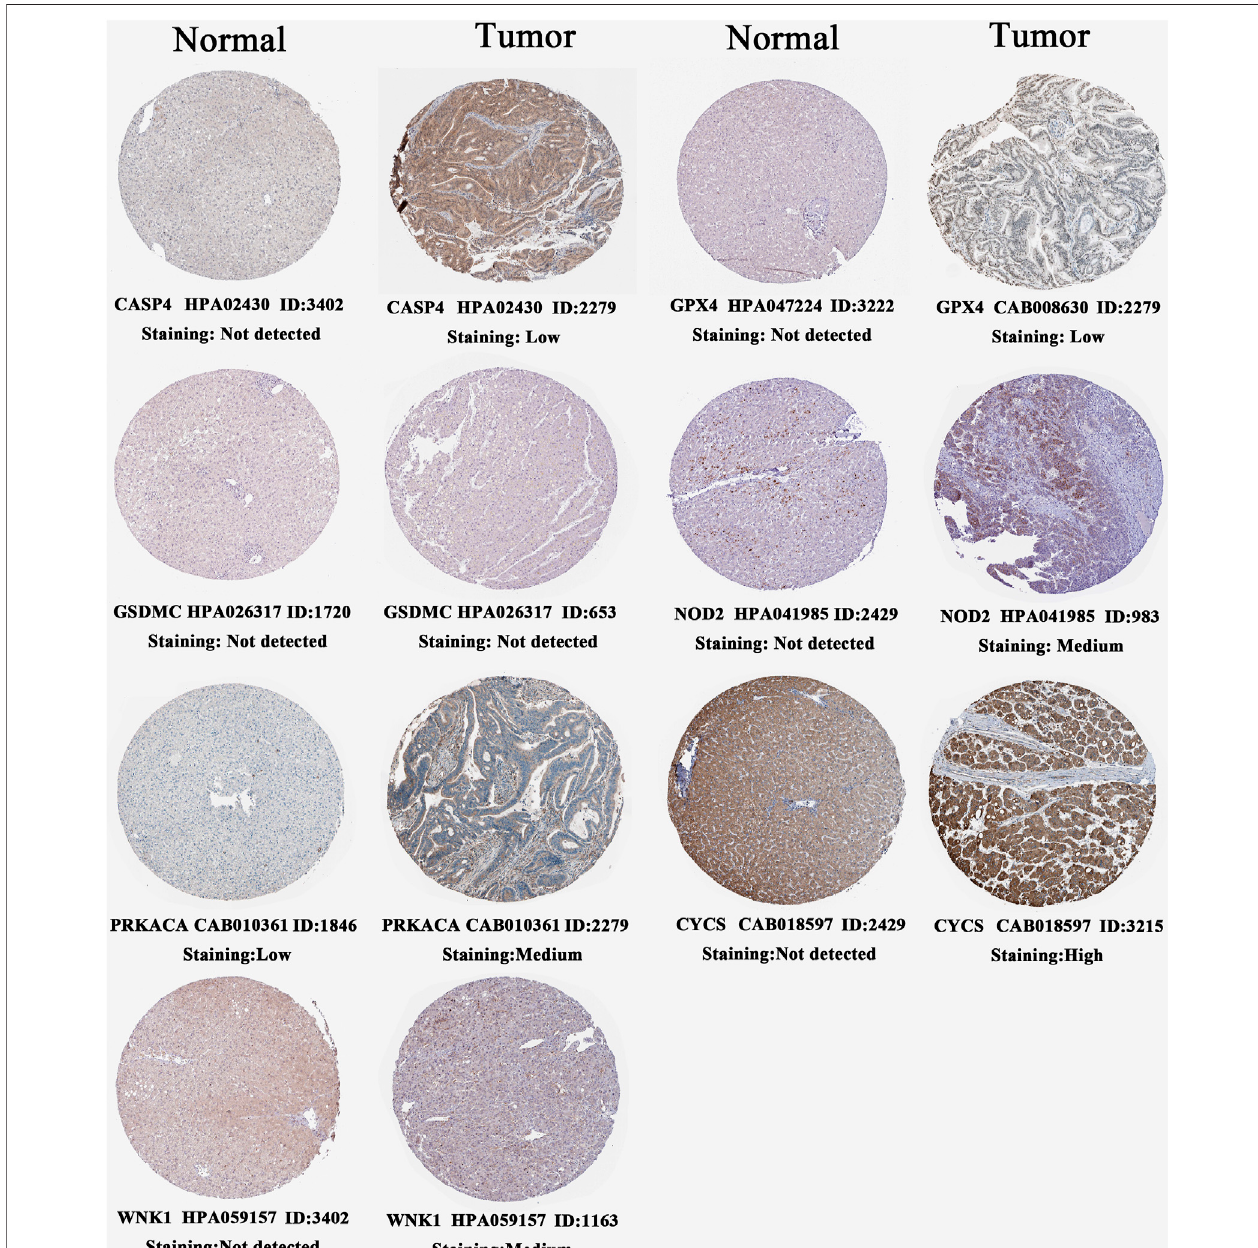
FIGURE 8 | Histological expressions of seven core PRGs based on the HPA database. The top of the fi gure indicates the category of the tissue specimen. The name of PRG, antibody type, patient ID, and staining intensity are listed at the bottom of each image. PRGs, pyroptosis-related genes.